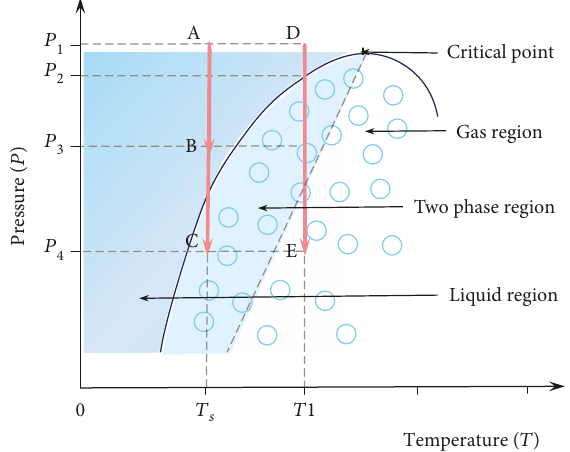
Figure 6: The A-B process is the traditional spray cooling. The A-C process is the fl ash evaporation spray cooling which is realized by pressure drop. The D-E process is the fl ash evaporation spray cooling which is realized by temperature